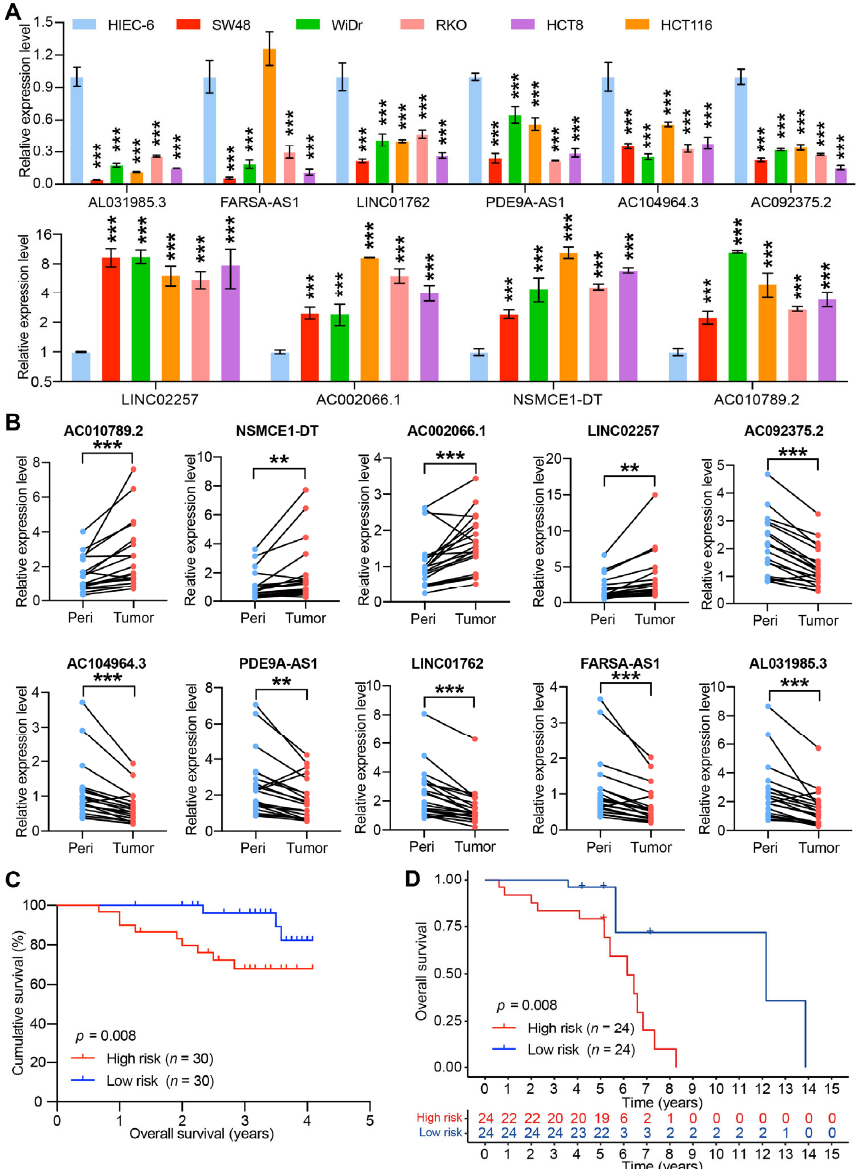
Figure 9. Validation for the expression level and predictive power of CRLs ‐ based risk score in CC cell lines and tissues. ( A ) Expression level of ten prognosis ‐ associated CRLs in five human colon cancer cell lines (RKO, HT8, HCT116, SW48, WiDr) and normal human intestinal epithelial cell (HIEC ‐ 6). ( B ) Expression level of ten prognosis ‐ associated CRLs in 20 paired CC and peritumoral tissue samples. ( C ) Survival analysis of CC patients layered by the CRLs ‐ risk score in cohort from the Sixth Affiliated Hospital, Sun Yat ‐ sen University ( p = 0.008). ( D ) Kaplan–Meier survival curve of OS in CC patients with high/low CRLs ‐ risk score from GSE152430 cohort (** p < 0.01 and *** p < 0.001).